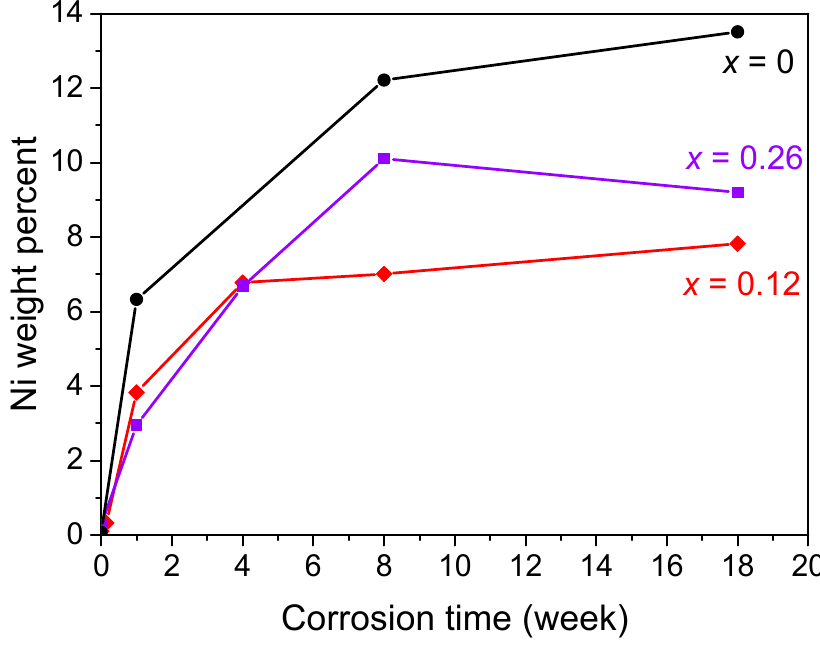
Figure 6. Weight percent of nickel formed as a function of corrosion time for Sm 2 Mn x Ni 7 − x ( x = 0: black; 0.12: red; 0.26: purple).